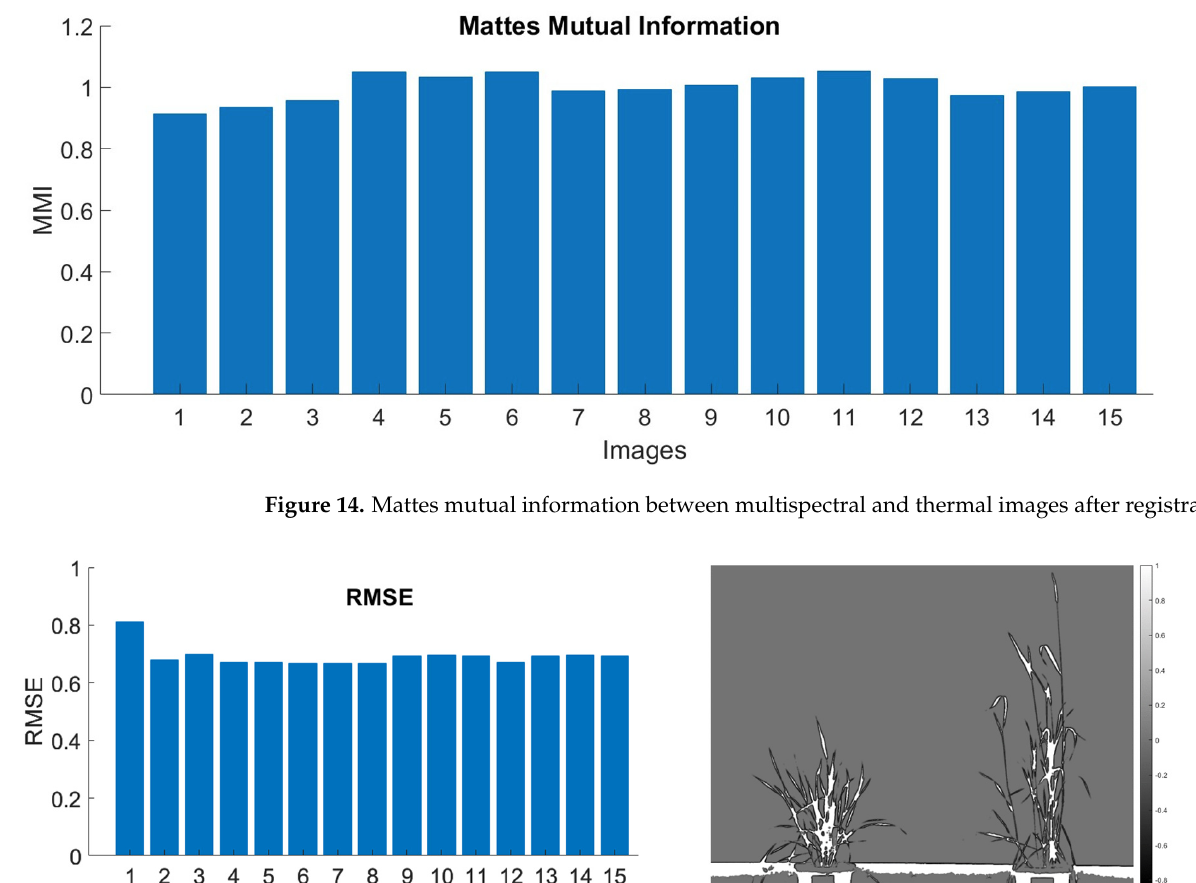
Figure 14. Mattes mutual information between multispectral and thermal images after registration.